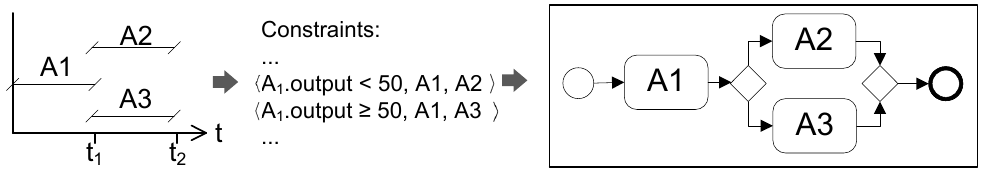
Figure 10. Exclusive Relationship.